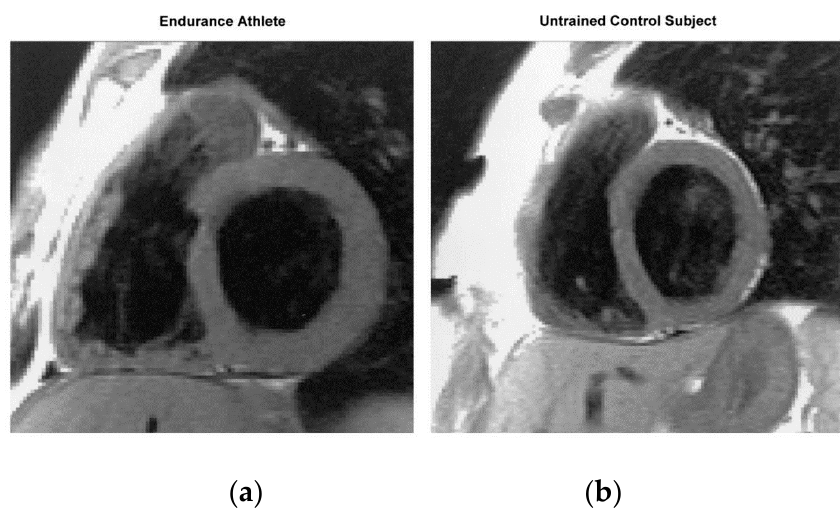
Figure 5. End-diastolic T1-weighted short-axis slice from an endurance athlete ( a ) and an untrained control subject ( b ). Compared with the heart of the control subject, the endurance athlete’s heart is characterized by an enlarged volume and a greater myocardial mass of both ventricles, while the proportions of the left and right heart are the same as in the untrained control subject. Taken with permission from Scharhag et al.